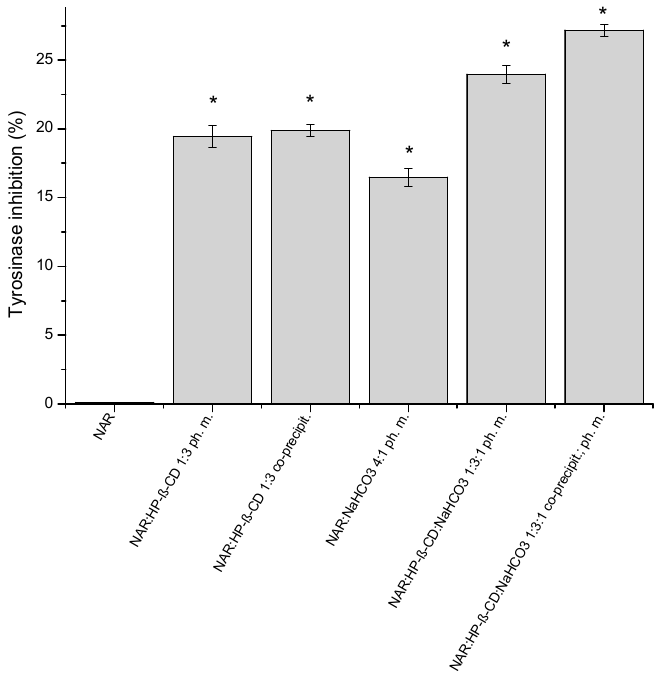
Figure 7. Tyrosinase inhibitory activity of NAR, the binary system (NAR:HP- β -CD) obtained by the co-precipitation method, the physical mixtures (NAR:HP- β -CD; NAR: NaHCO 3 ), the ternary system (NAR:HP- β -CD:NaHCO 3 ), and the physical mixture (NAR:HP- β -CD:NaHCO 3 ). (*) indicates statistically significant differences, p < 0.05.